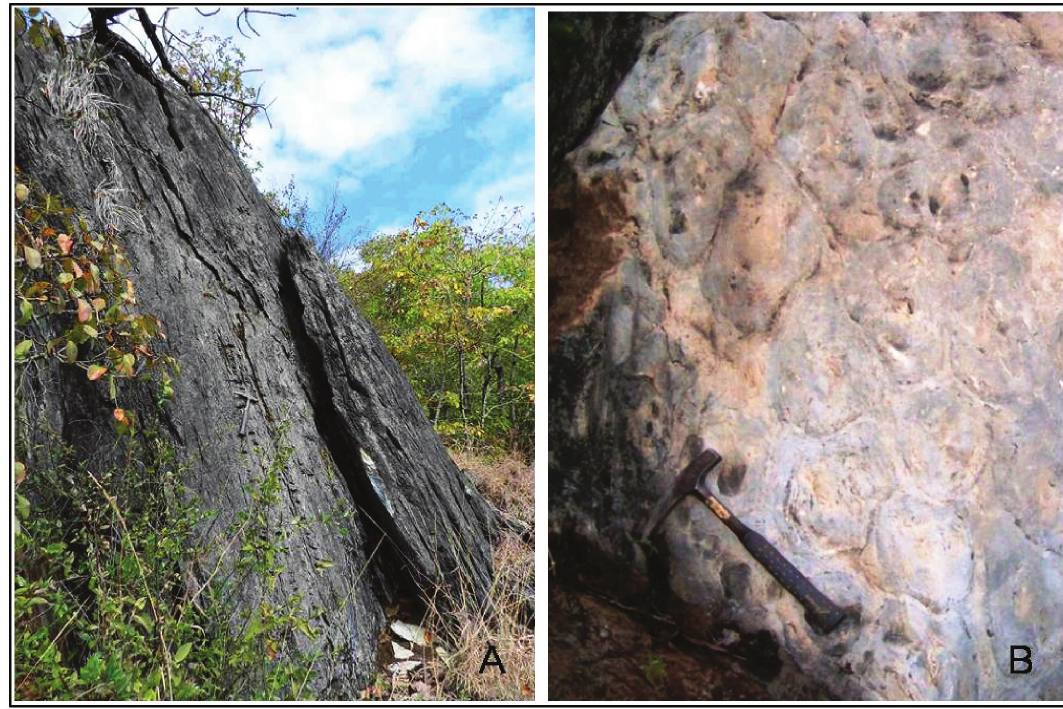
Figure 6 - Outcrop of columnar estromatolitic structures containing gray dolostone (A) at the Boqueirão Farm. Stromatolites have elliptical shape in basal section, branched or unbranched, with micrite deposition in the free space (B)